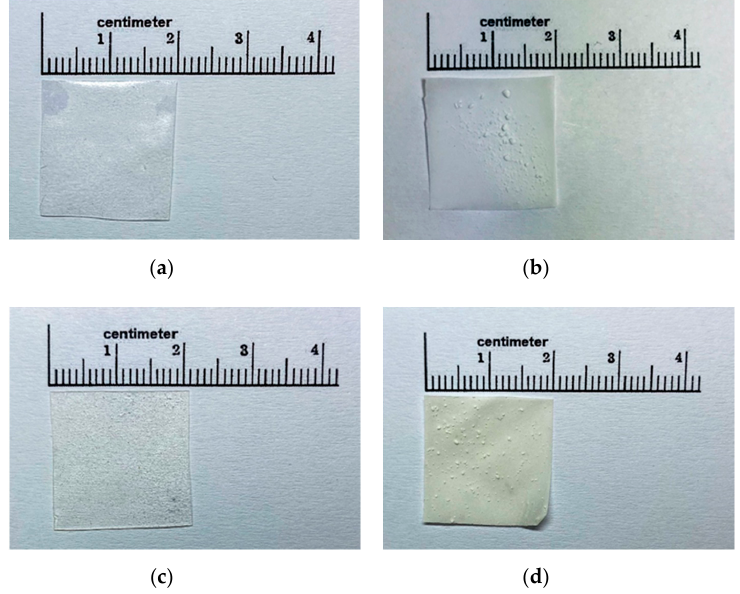
Figure 1. Gross appearance of polyvinyl alcohol (PVA)-S4 ( a ), PVA-No ( b ), high methoxyl pectin (HMP)-S4 ( c ) and HMP-No ( d ) phenytoin orally disintegrating films (ODFs). Table 3. Weight, thickness and surface pH of phenytoin orally disintegrating films (ODFs).